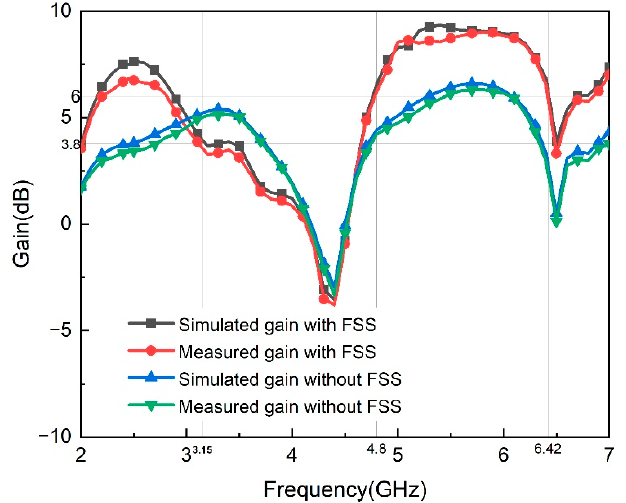
Figure 14. The comparison of the simulated and measured gain of the proposed antenna with and without an FSS.